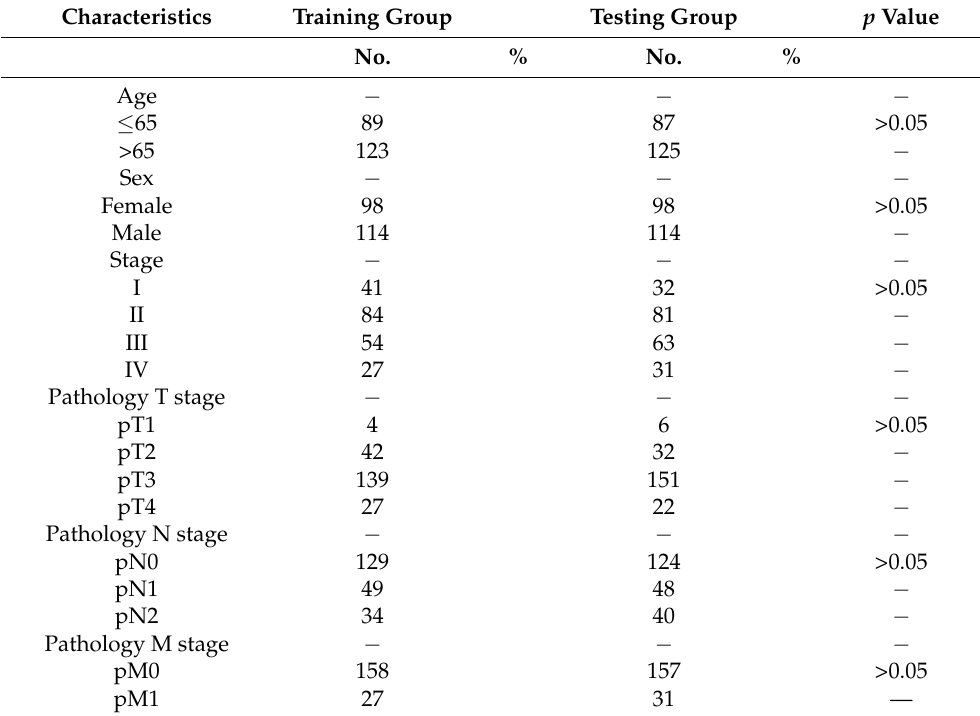
Table 1. The clinical characteristics of CRC patients in the training and testing groups.